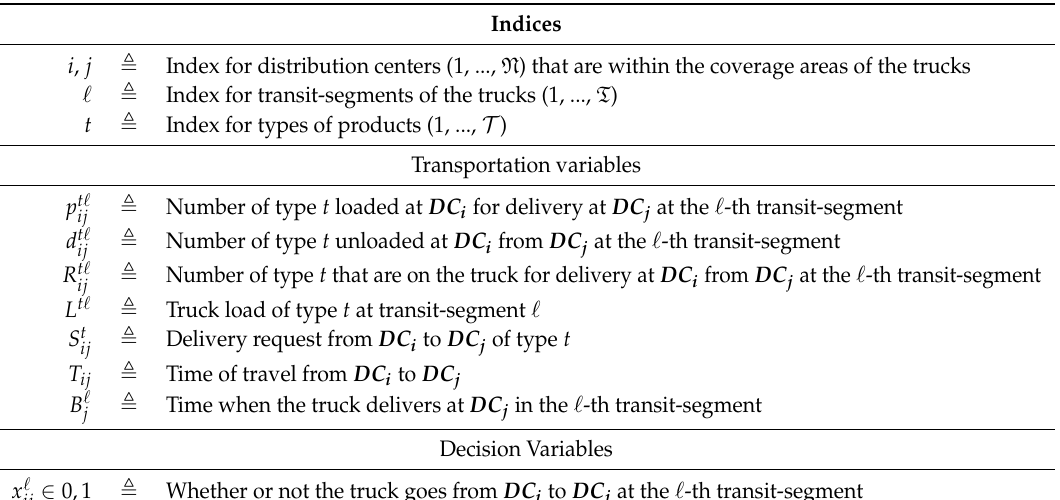
Table 2. Table of